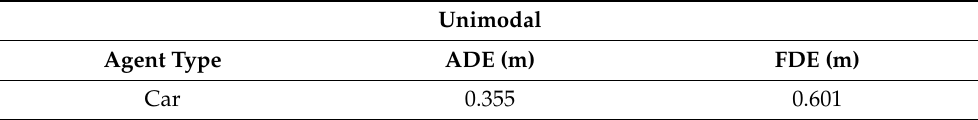
Table 5. Unimodal results with fewer predicted points.